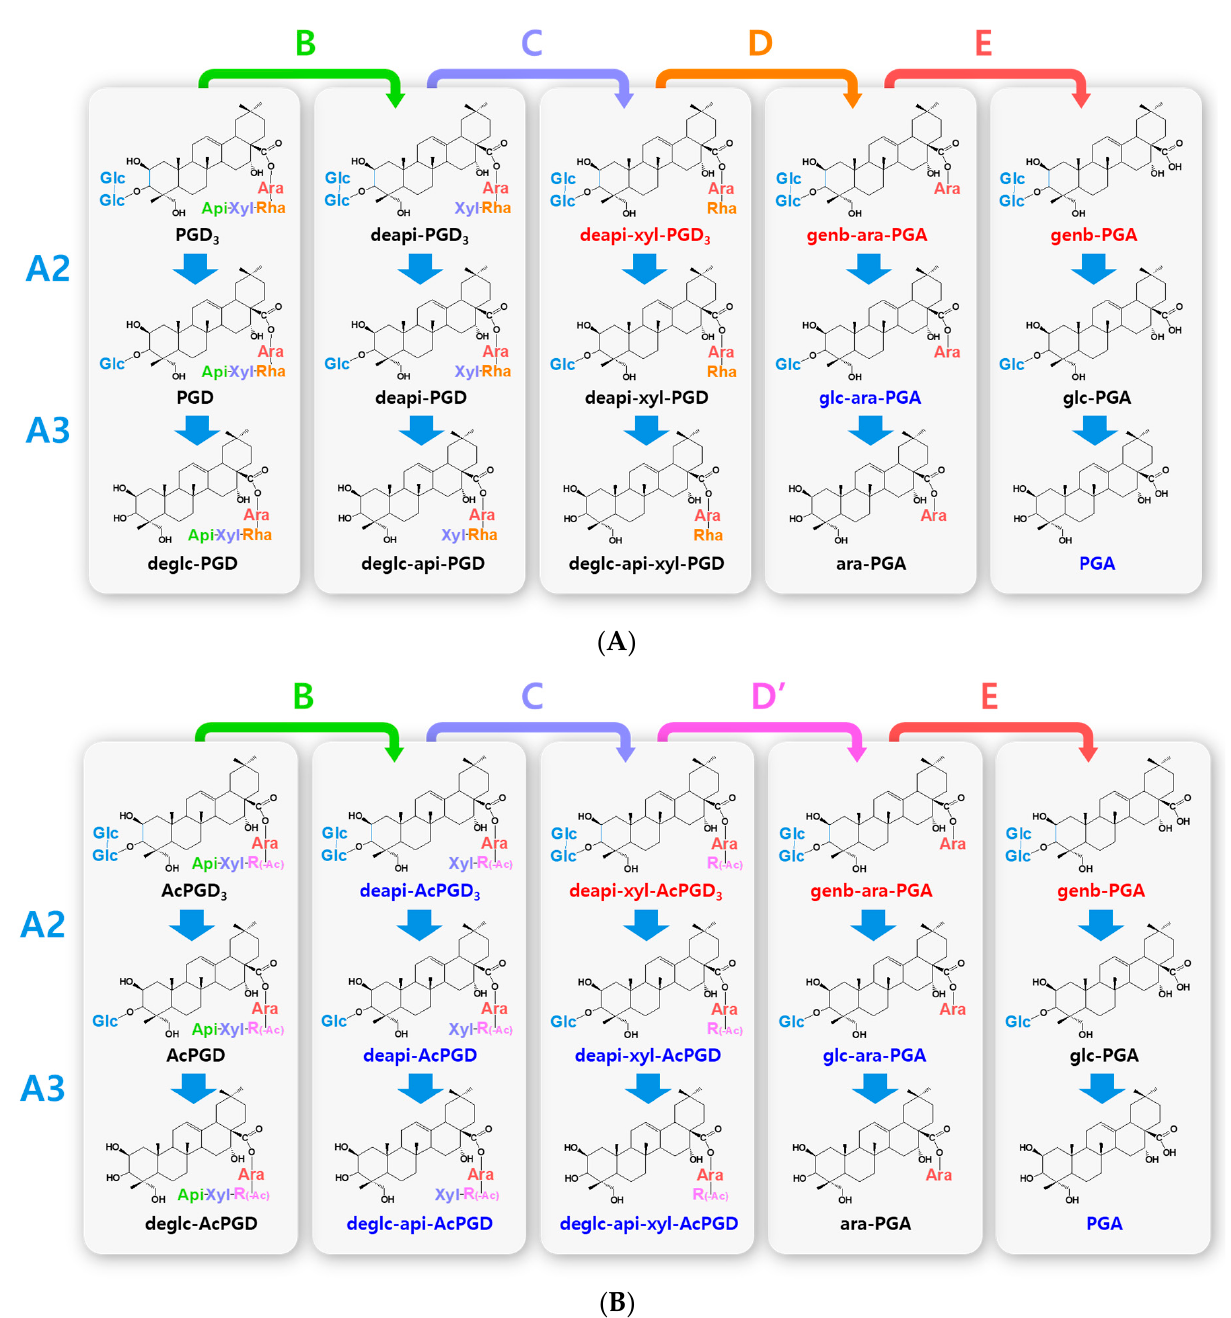
Figure 3. Hydrolytic pathways of the PGA-type platycosides by glycosidases. The hydrolytic pathways of the outer and inner glucoside residues linked to C-3 by β - D -glucosidases are assigned as A2 and A3, respectively. The hydrolytic pathways of the four residues, including apioside, xyloside, rhamnoside or acetyl-rhamnoside, and arabinoside, linked to C-28 in PDN-type platycosides by β - D -apiosidase, β - D -xylosidase, α - L -rhamnosidase, and α - L -arabinosidase are assigned as B, C, D or D ′ , and E, respectively. ( A ) Hydrolytic pathways from PGD 3 to PGA. ( B ) Hydrolytic pathways from AcPGD 3 to PGA. R(-Ac), acetyl- α - L -rhamnopyranosyl-. Blue indicates unreported platycosides, which can be suggested by the reported glycosidases. Red indicates unreported platycosides, which cannot be suggested by the reported glycosidases.